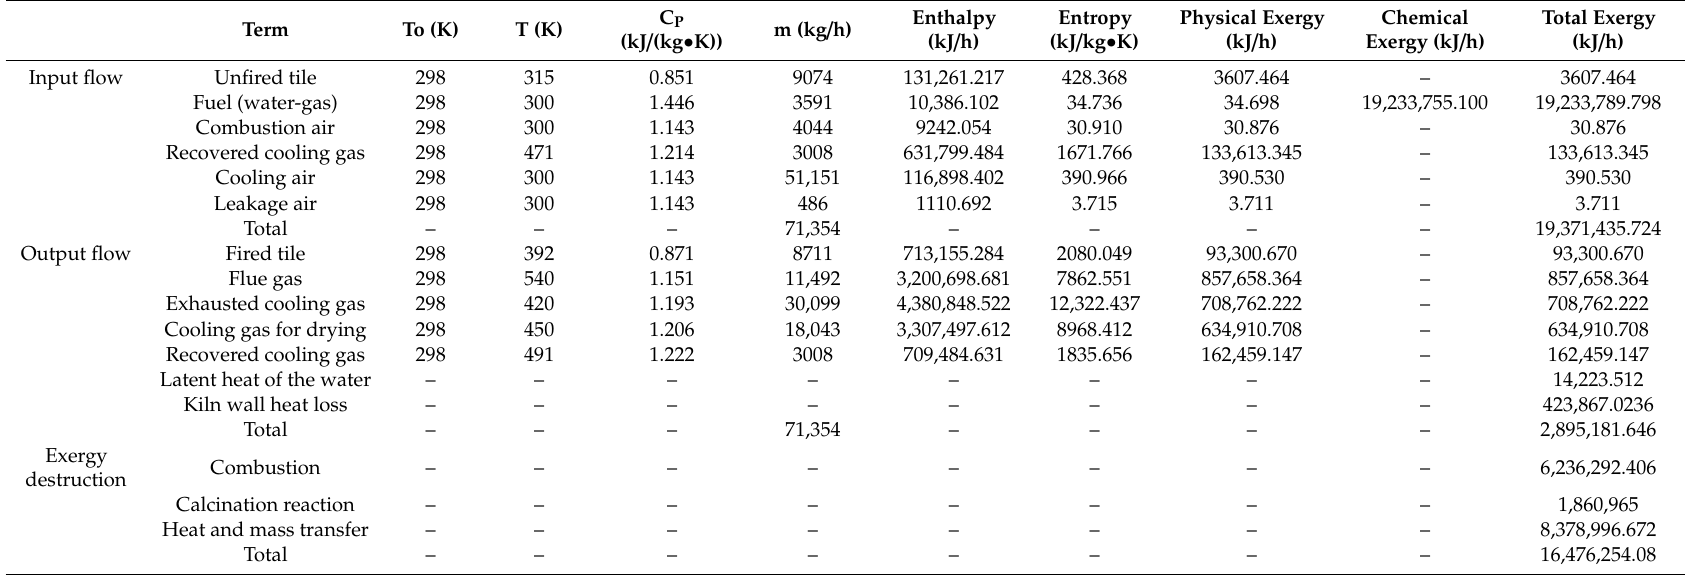
Table 11. Exergy flow of the roller